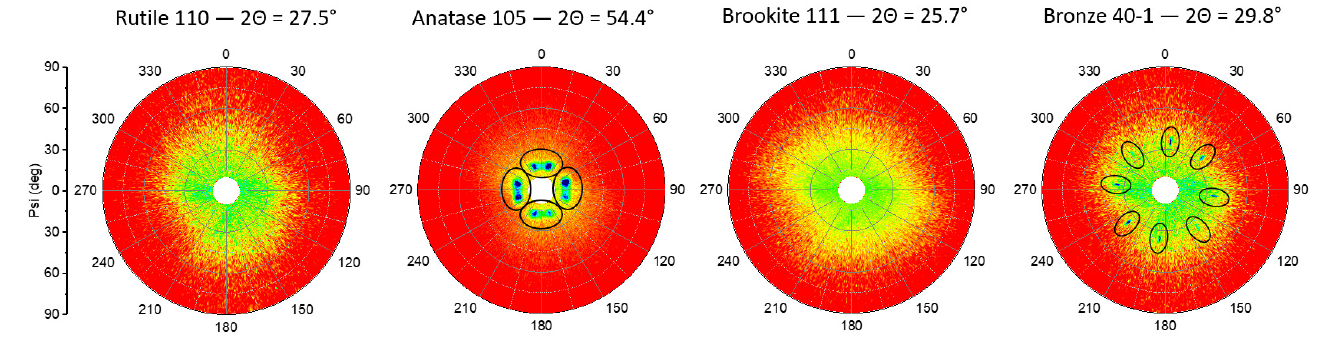
Figure 1. 2 θ - θ scans of TiO 2 films grown on various substrates. While high-quality epitaxial anatase and low-quality polycrystalline rutile are crystallized on LAO and MgO substrates, respectively, it will be shown that phase-pure bronze TiO 2 is stabilized on MAO substrates and buffer layers.